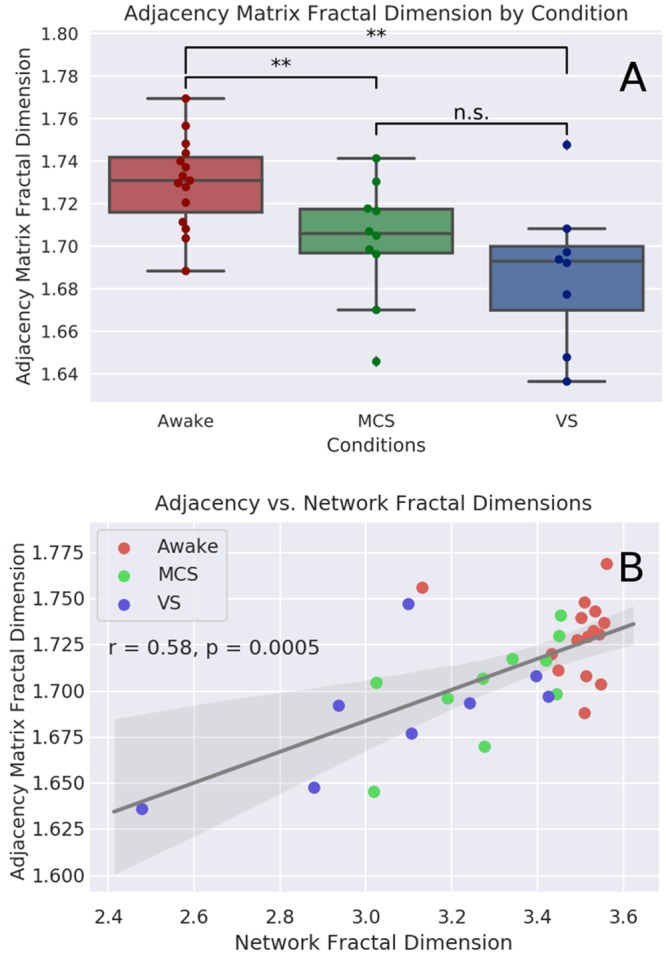
Adjacency matrix FD analysis.A: Visualization of the fractal dimension of functional connectivity networks as determined by FracLac analysis of the isomorphic two-dimensional adjacency matrix. Median value for the healthy controls: 1.731 (IQR: 1.716-1.742), for the MCS patients: 1.706 (IQR: 1.697-1.717), and for VS patients: 1.693 (IQR: 1.67-1.7). Post-hoc analysis with the Mann-Whitney U test found significant differences between the control and MCS conditions (H(33), p-value = 0.01), and the control and VS conditions (H(18), p-value = 0.0036), but not the VS and MCS conditions (H(25), p-value = 0.099). B: shows the correlation between the network fractal dimension (as calculated with the compact box burning algorithm), and the associated adjacency matrix fractal dimension (as calculated with FracLac).